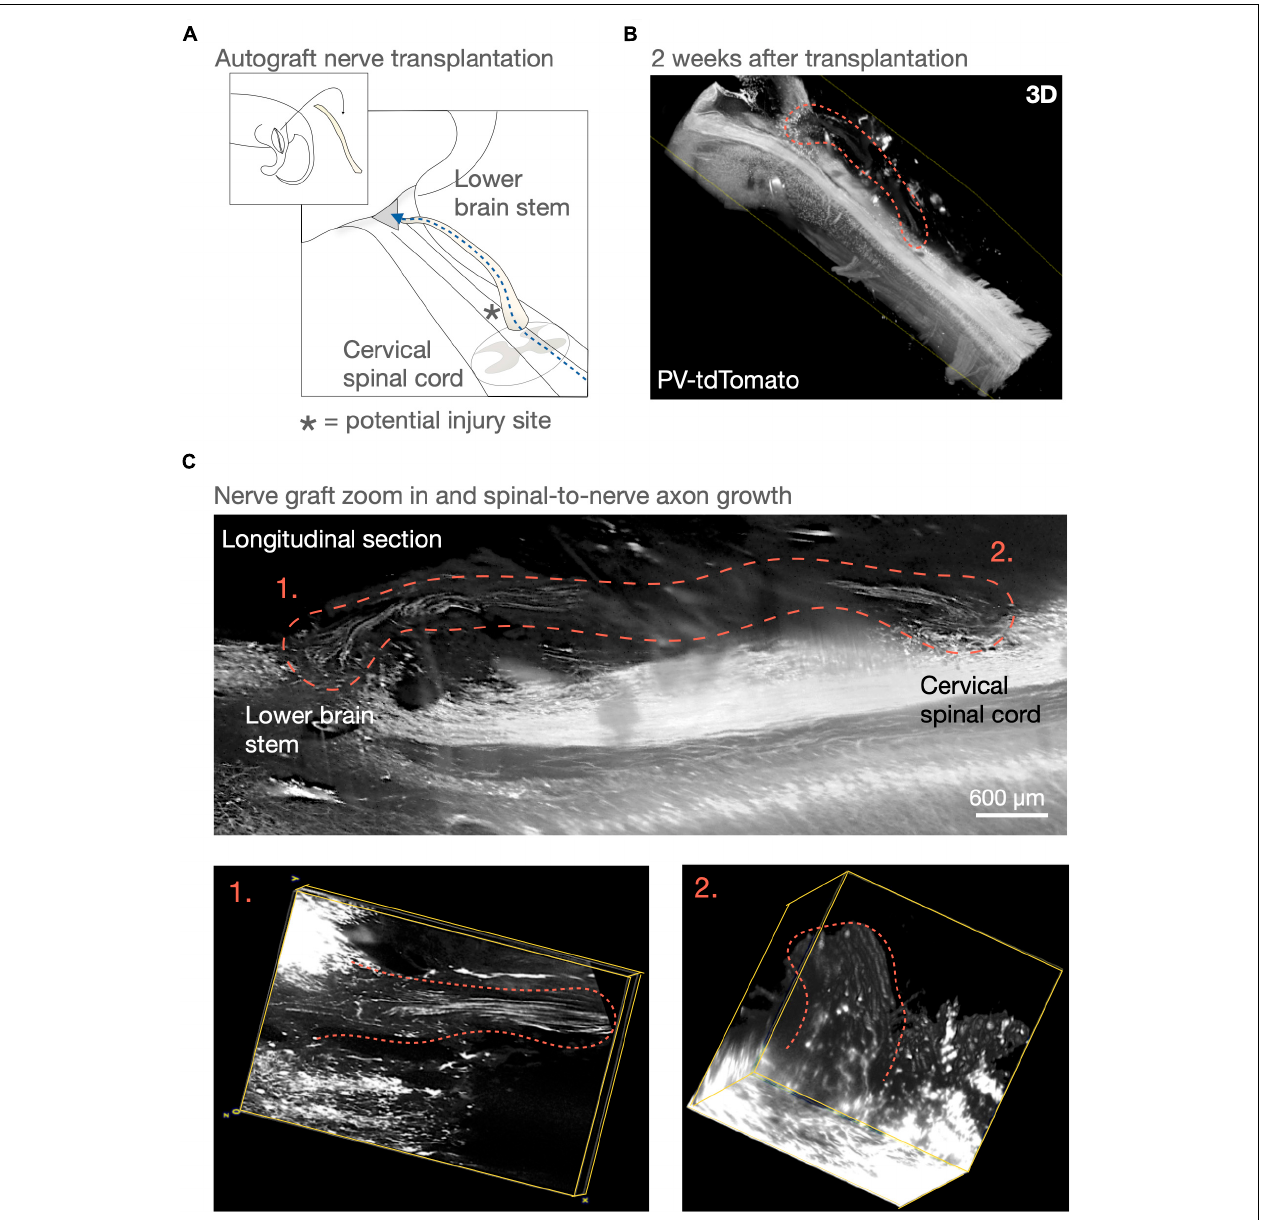
FIGURE 1 | Peripheral nerve graft (PNG) and repairing the sensory tracts of the dorsal column. In 1981, David and Aguayo (1981) demonstrated long distance axon growth using a peripheral nerve as a bridge for dorsal column axons. This experimental model aimed at demonstrating long-distance regeneration. However, using one or more PNGs as an axon bypass in a similar manner could be a potential repair strategy for incomplete spinal cord injuries that wouldn’t necessitate removing the spinal scar. (A,B) Here in a similar surgery model to David and Aguayo’s (1981) PNG “bridge” model, we visualize parts of the sensory tracts of the dorsal column in the lower brain stem and cervical spinal cord using a parvalbumin-reporter mouse (PV-tdTomato mouse). (C) An autologous PNG is transplanted and 2 weeks after transplantation we can visualize axons throughout the PNG. To follow axons throught the cord in 3D was not possible at the time of Aguayo’s (1985) experiment and our understanding of using PNG as a repair strategy for the spinal cord has advanced. Such techniques and knowledge may today allow us to obtaining necessary answers for potentially considering advancing PNG transplantation as a long-distance axonal tract repair for incomplete spinal cord